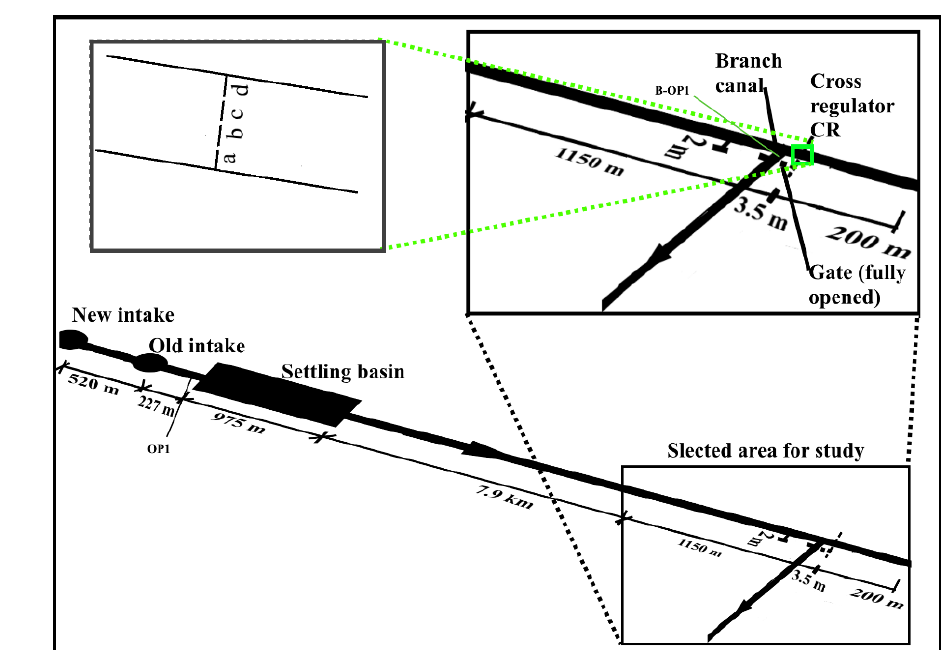
Figure 6. The selected area.